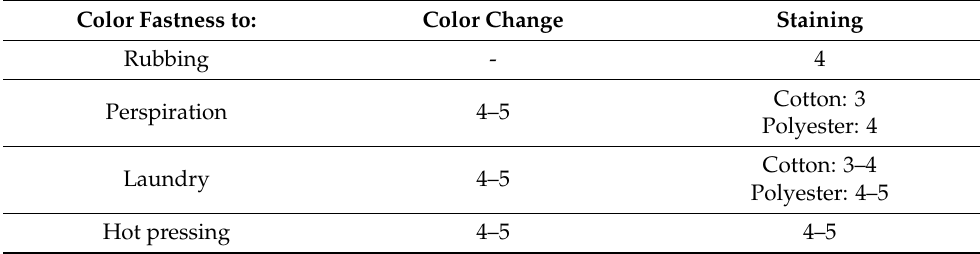
Table 3. Material requirements according to EN17353.